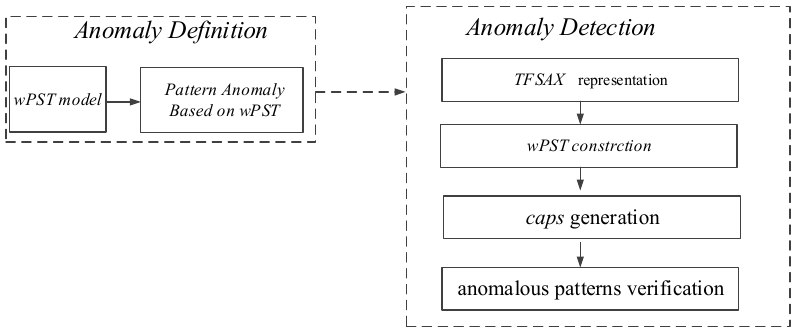
Figure 2. Framework of the Trend Feature Symbolic Aggregate approximation and weighted PST approach ( TFSAX_wPST ) .